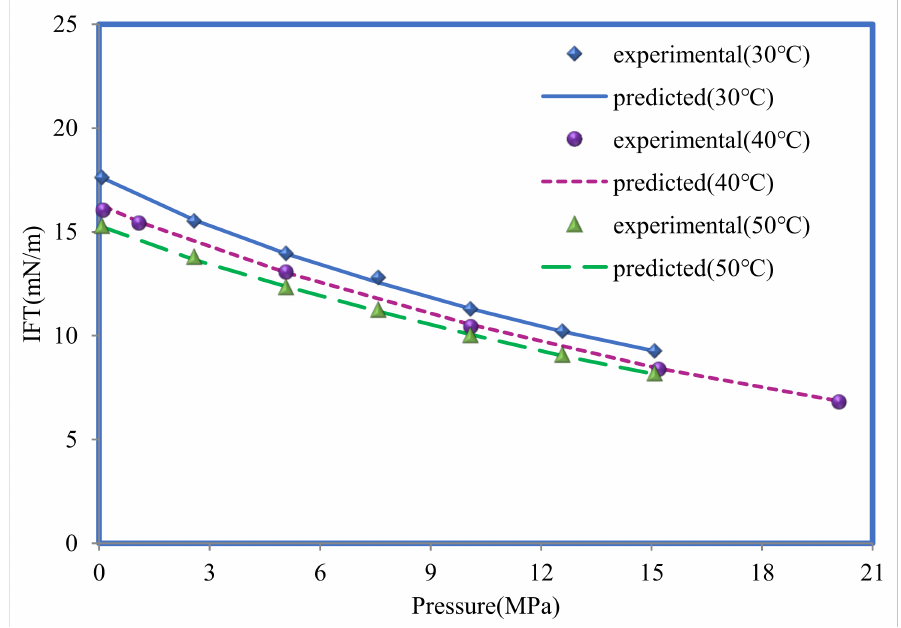
Figure 10. The experimental values and RBF predictions for the IFT of N 2 /CO 2 mixture + n-hexane.